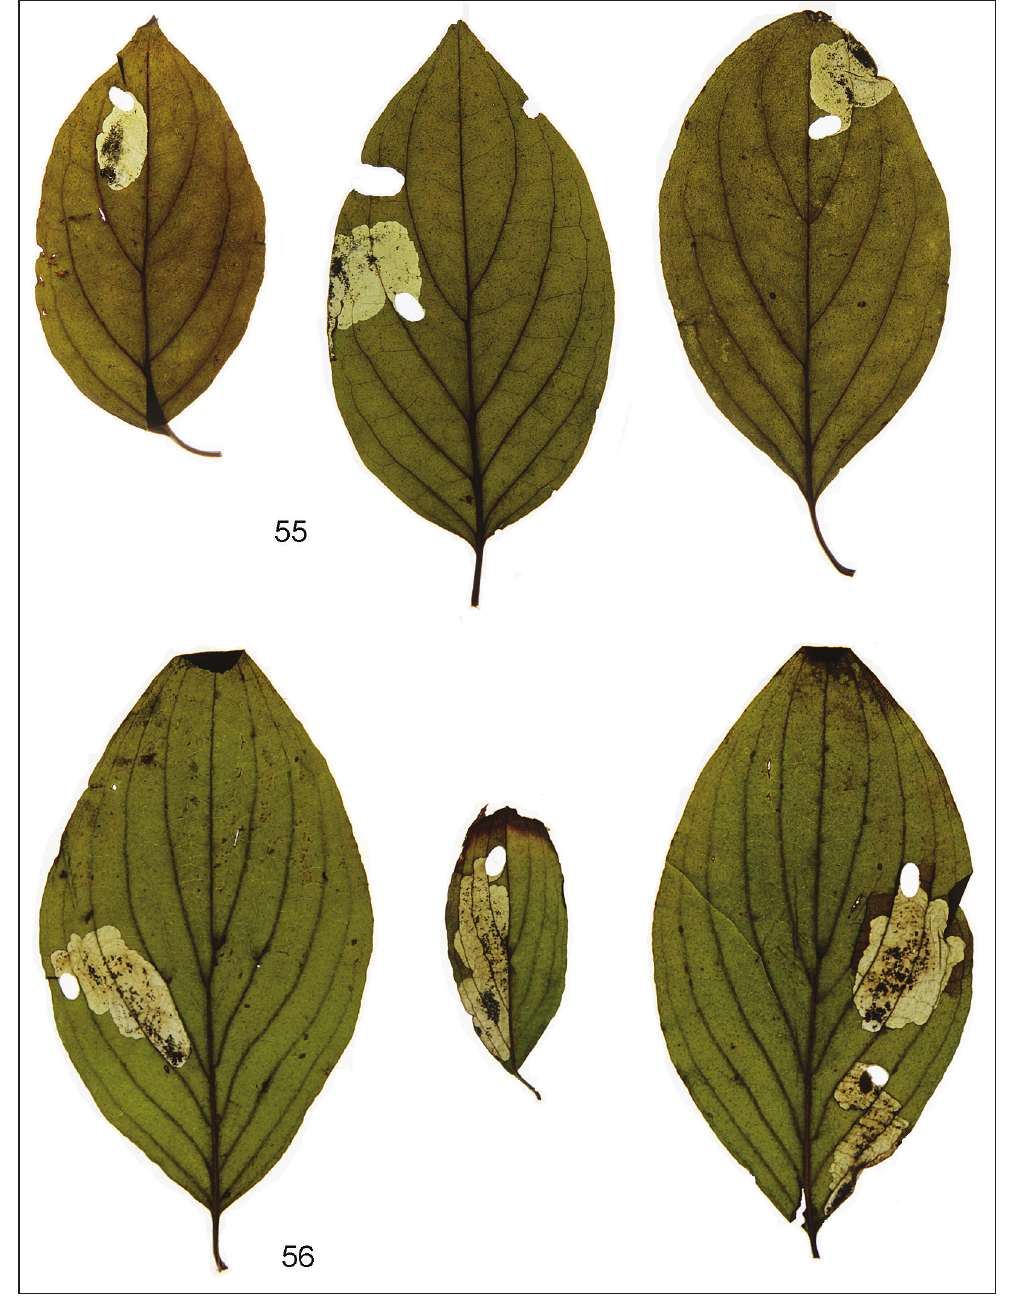
Figures 55–56. Antispila species, leaves of Cornus with vacated leafmines, dry collection RMNH. 55 C. sanguinea with A. petryi , RMNH.INS.41141, Netherlands, Limburg, Geulhem, 26.viii.1949, C. Doets 56 C. mas with A. treitschkiella , RMNH.INS.40829, Netherlands, Zuid-Holland, Leiden, 17.x.2004, E.J. van Nieukerken. Photos Erik van